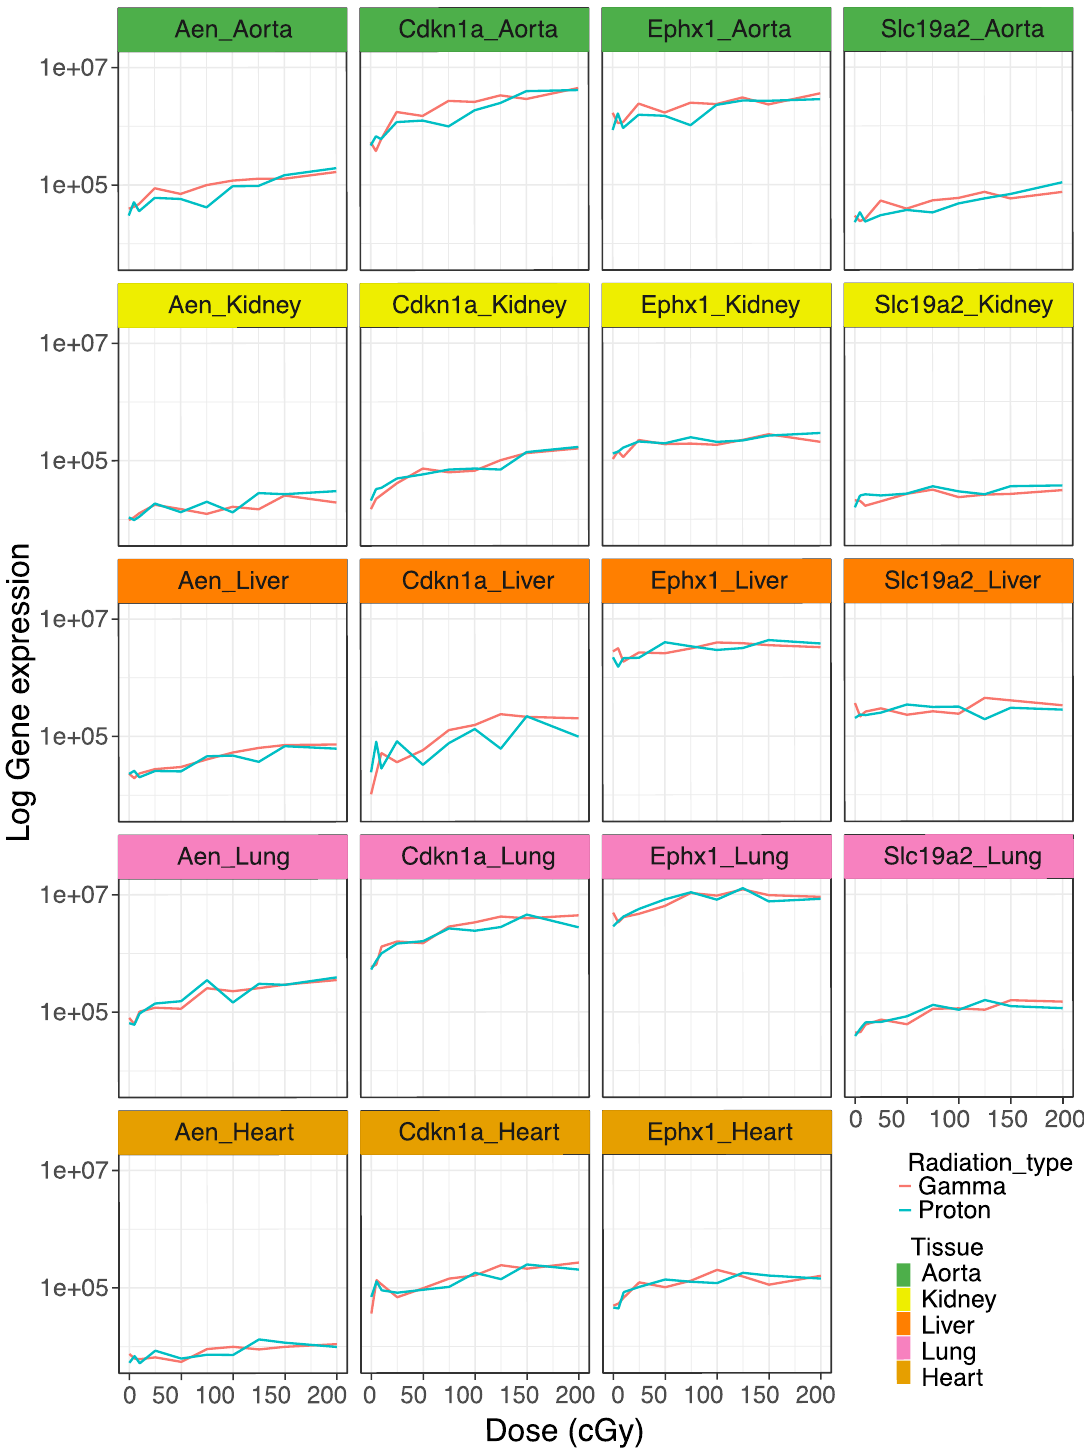
Fig 5. Validation of gene expression. Dose-dependent effects of gamma and proton radiation on Aen, Cdkn1a, Ephx1 and Slc19a2 expression in aorta, kidney, lung and heart. Gene expression was measured by quantitative RT-PCR.